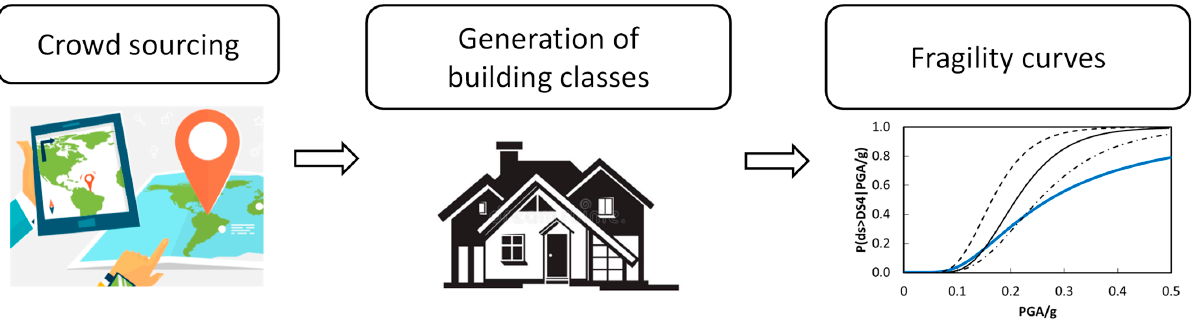
Figure 1. Flow chart of the methodology.